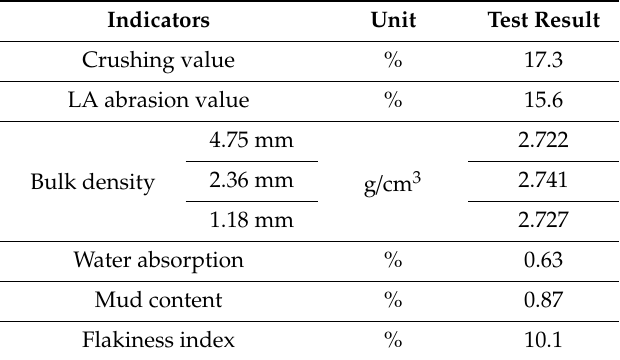
Table A1. Technical indicators of coarse aggregate.